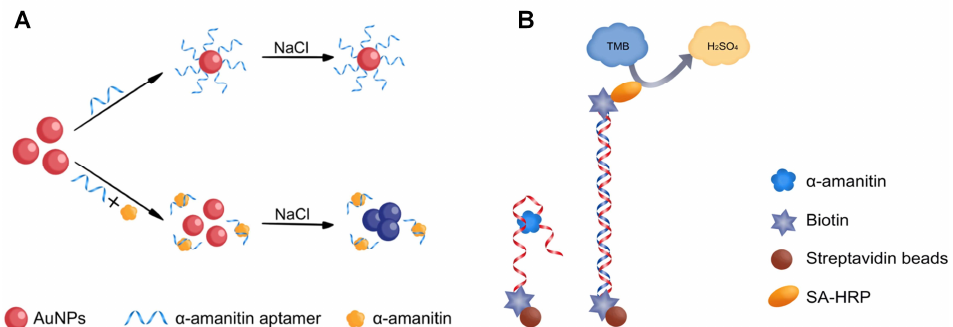
Figure 1. Experimental schematic. ( A ) Schematic illustration of the affinity of the α-amanitin truncated aptamer by colloidal gold spectrophotometry. ( B ) Schematic illustration based on MELISA to detect α-amanitin.